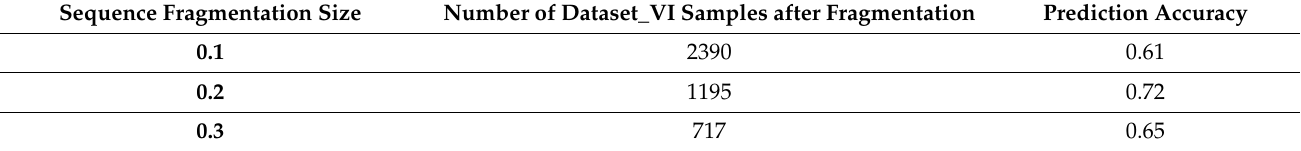
Figure 18. The reported average execution times of: (a) studying Dataset_VI with Model_0; (b) applying Model_I, Model_II, and Model_II to fragmented Dataset_VI (fragmentation size = 0.2). Table 5. The results of Ex09 . Sequence Fragmentation Size Number of Dataset_VI Samples after Fragmentation Prediction Accuracy